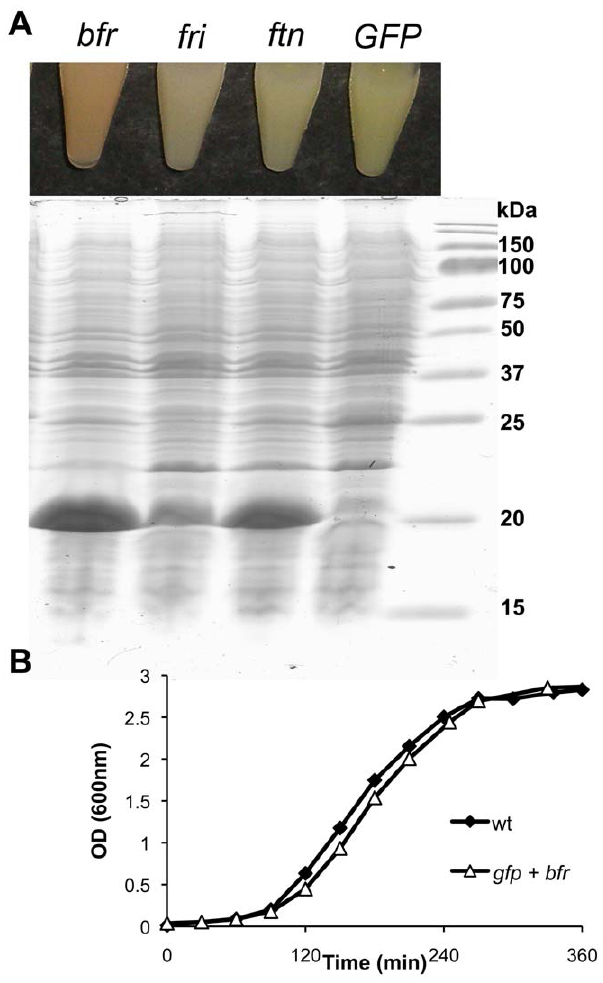
Figure 1. Expression of various bacterial ferritin-like proteins in Ec N. A ) The over-expression of heme containing Bfr results in a color change of the bacteria (upper picture, left tube). The overexpression of Bfr (18.4 kDa), Fri (18.0 kDa), and Ftn (19.3 kDa) was confirmed by Coomassie-stained SDS-PAGE gels. B ) Only minimal effects on bacterial growth were observed when wild-type (wt) Ec N or GFP - and bfr - encoding Ec N ( gfp + bfr ) were grown in BHI. Standard deviation ( , 2%) of measured values is not